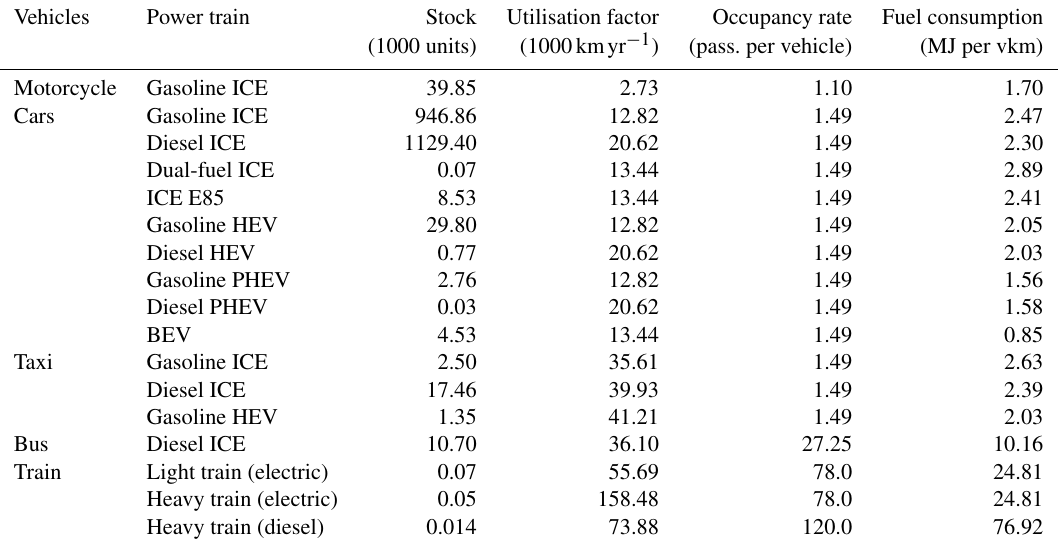
vkm: vehicle kilometres.